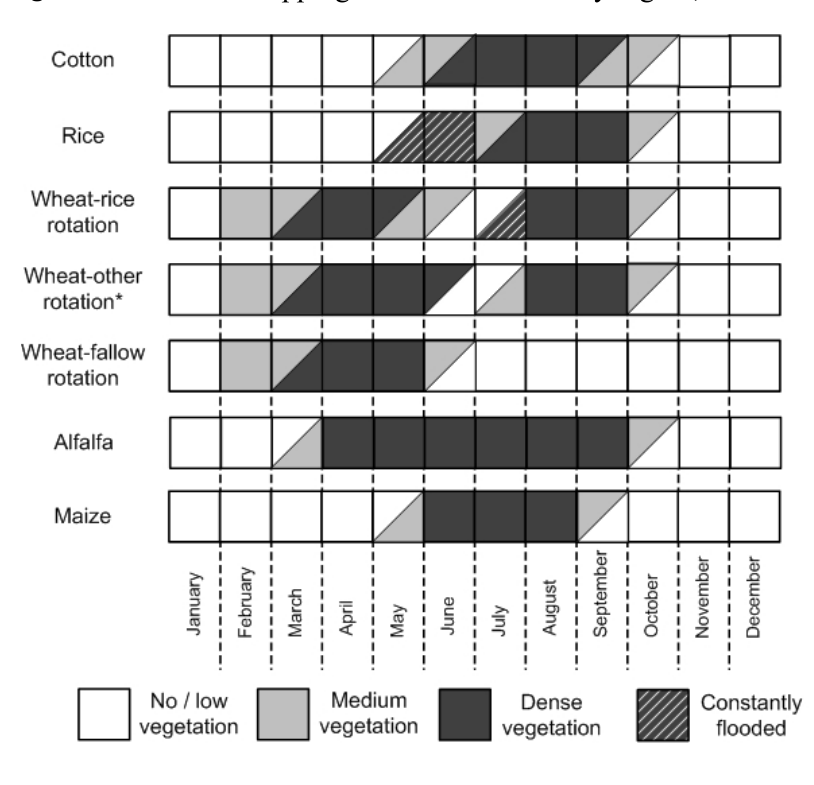
Figure 2. Idealized cropping calendar of the study region,